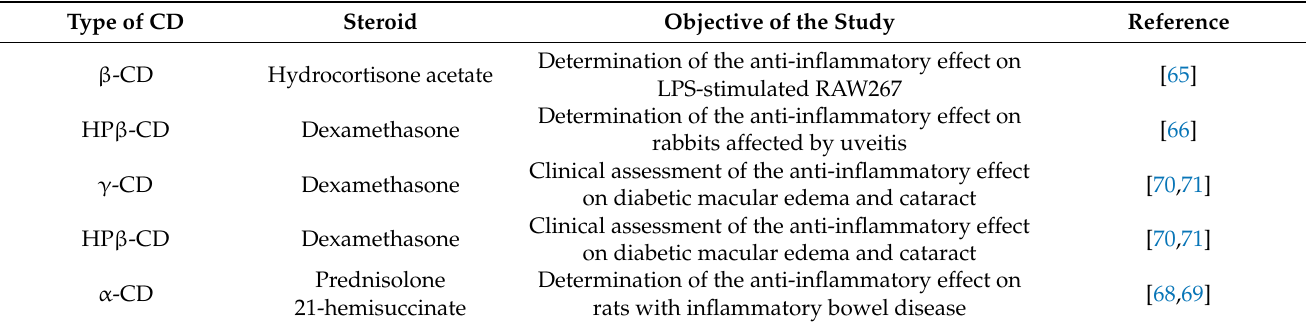
Table 2. Studies conducted on CD-steroid